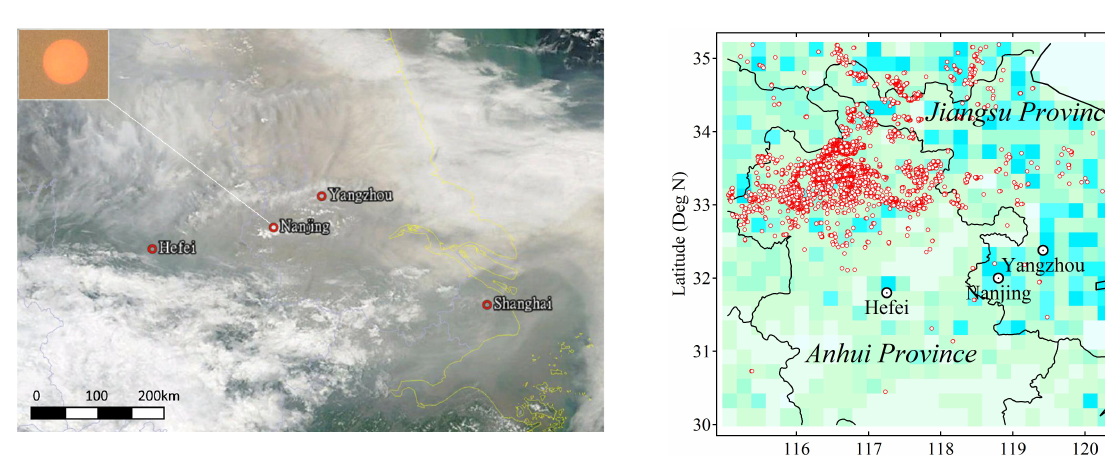
Fig. 1. A Terra satellite true color image of East China on 10 June, 2012. Note: the satellite images were provided by MODIS Rapid Response Subsets of NASA. The top left corner gives a photo of the sun seen from the ground at 10:30LT of 10 June 2012 in Nanjing.